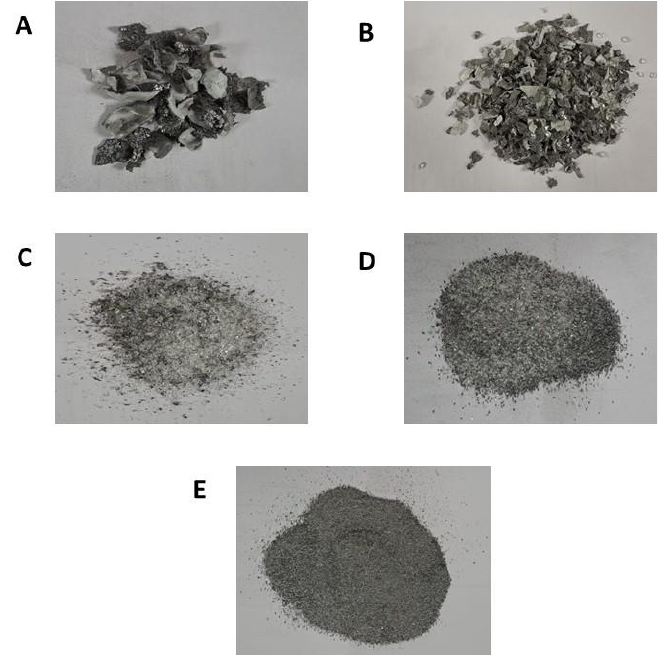
Figure 2. Crushed and screened sample divided into different fractions according to particle size, ( A ) fraction of +5.6 mm, ( B ) fraction of +2 mm, ( C ) fraction of +0.5 mm, ( D ) fraction of +0.25 mm, ( E ) fraction of − 0.25 mm. Table 2. XRF for sample of EOL solar panels used in study.